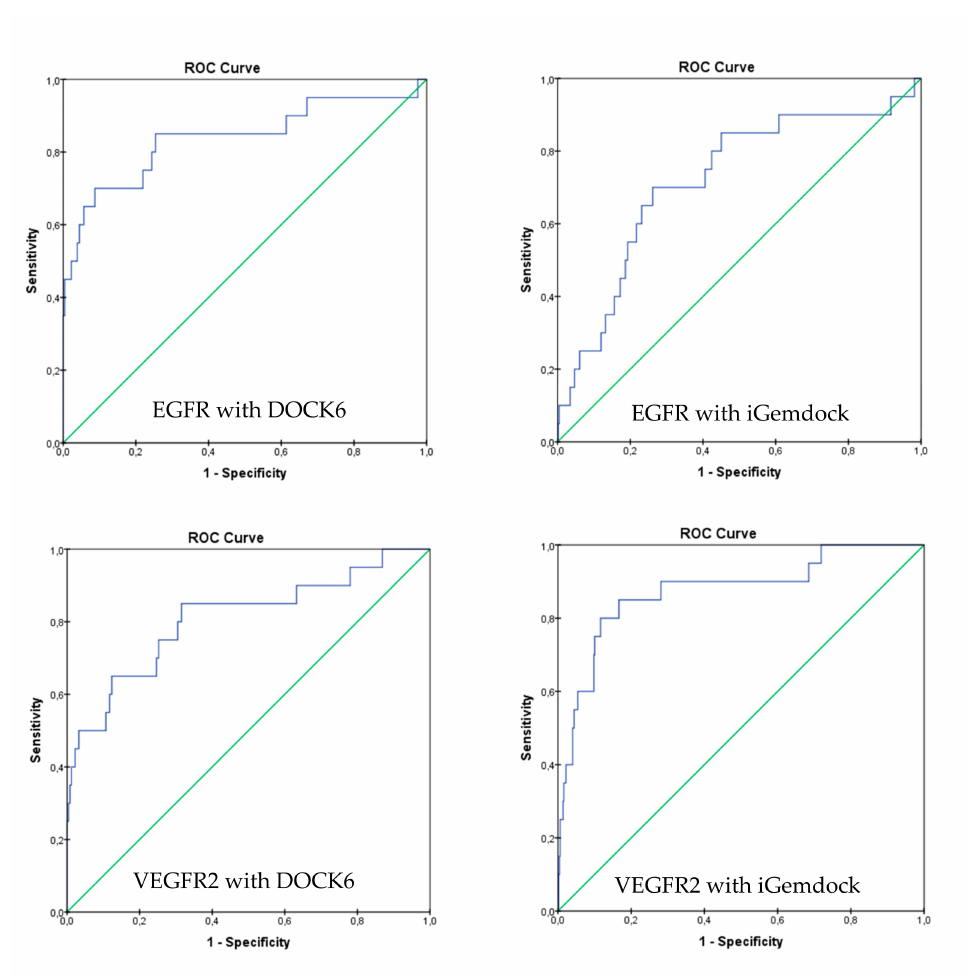
Figure 3. Receiver operating characteristic (ROC) curve validation of docking protocols using DOCK6 and